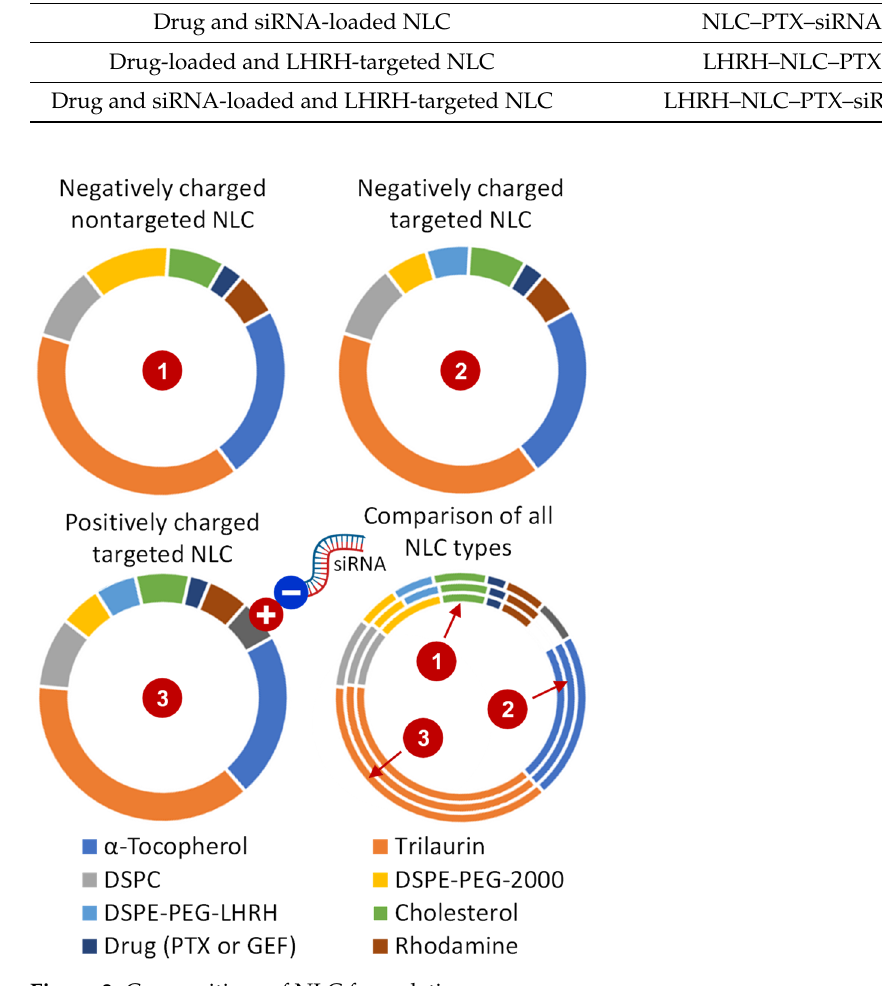
Figure 3. Compositions of NLC formulations. Table 1. The list of all NLC formulations.